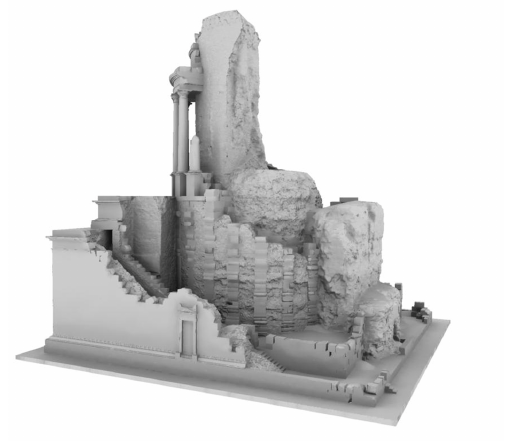
Figure 3. 3D model of the building current state elaborated mixing laser scanning and photogrammetry